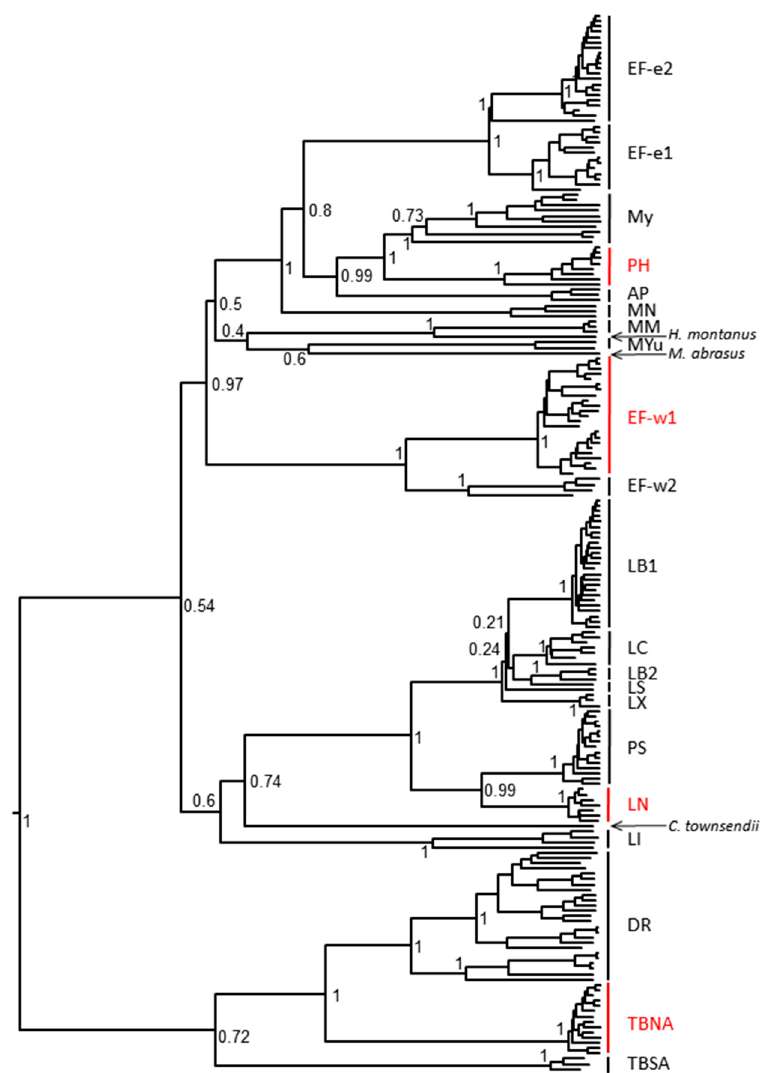
Figure 1. Phylogenetic relationship of rabies virus isolates used in this study with other representatives of bat RABV lineages. RABV used in this study are highlighted in red (PH— Parastrellus hesperus , Ef-w1— E. fuscus western lineage 1, LN— Lasionycteris noctivagans , TBNA— Tadarida brasiliensis North America).